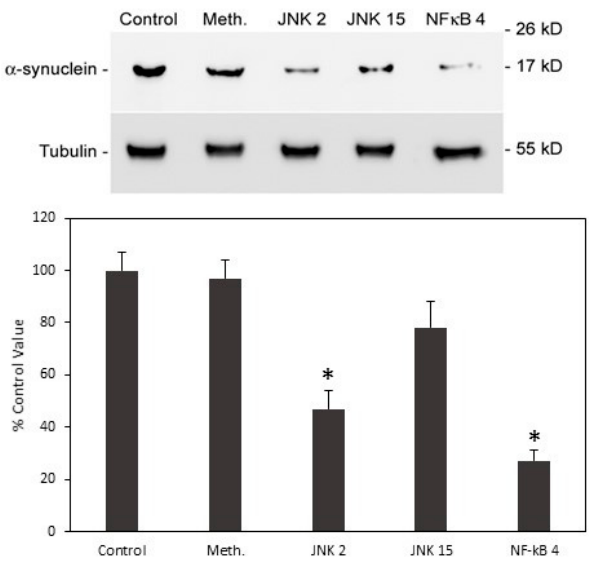
Figure 10. Inhibitors of signaling pathways. In order to assess the role of both the JNK pathway and NF- κ B pathway in the increased expression of α -syn in response to conditioned medium from iron-fed C8B4 microglia, we applied a series of inhibitors of these pathways to SH-SY5Y cells during treatment with the conditioned medium. The compounds used were two inhibitors of the JNK pathways (JNK 2 and JNK 15) and one inhibitor of the NF- κ B pathway (NF- κ B 4). As the inhibitors were soluble in methanol we also included a methanol control at the highest volume used. After a 24 h treatment, the levels of α -syn and tubulin were assessed by western blot. The strongest inhibition was seen with the NF- κ B 4 inhibitor. The inhibitory effect of JNK 2 was also significant ( p < 0.05) but the effect of JNK 15 was not. Shown are the mean and S.E.M. of four separate experiments.